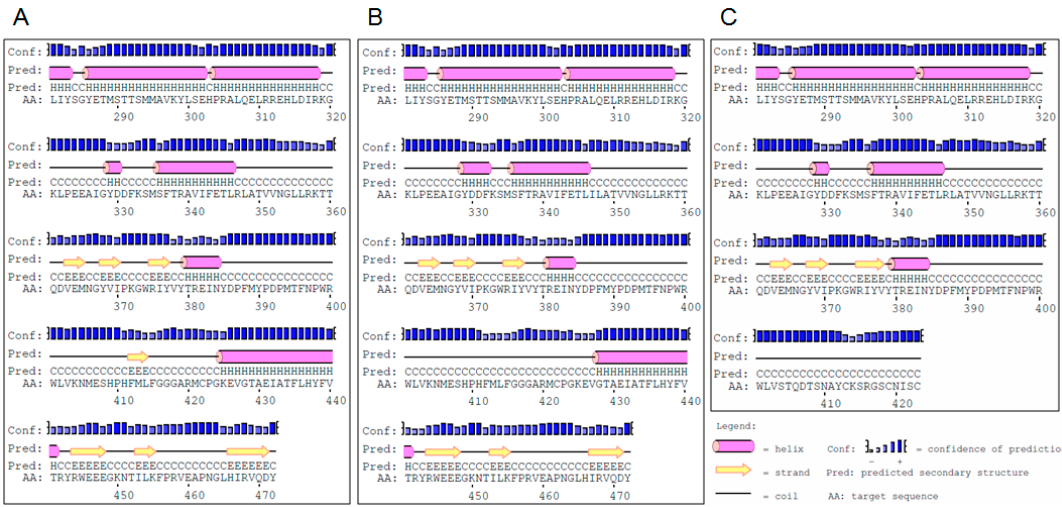
Figure 3. The arrangement of secondary spatial domains in the rearmost part of the HvDWARF proteins in the parent variety “Sebastian” ( A ); protein version encoded by the brd1-c allele ( B ); and in the truncated form encoded by the allele brd1-d ( C ).